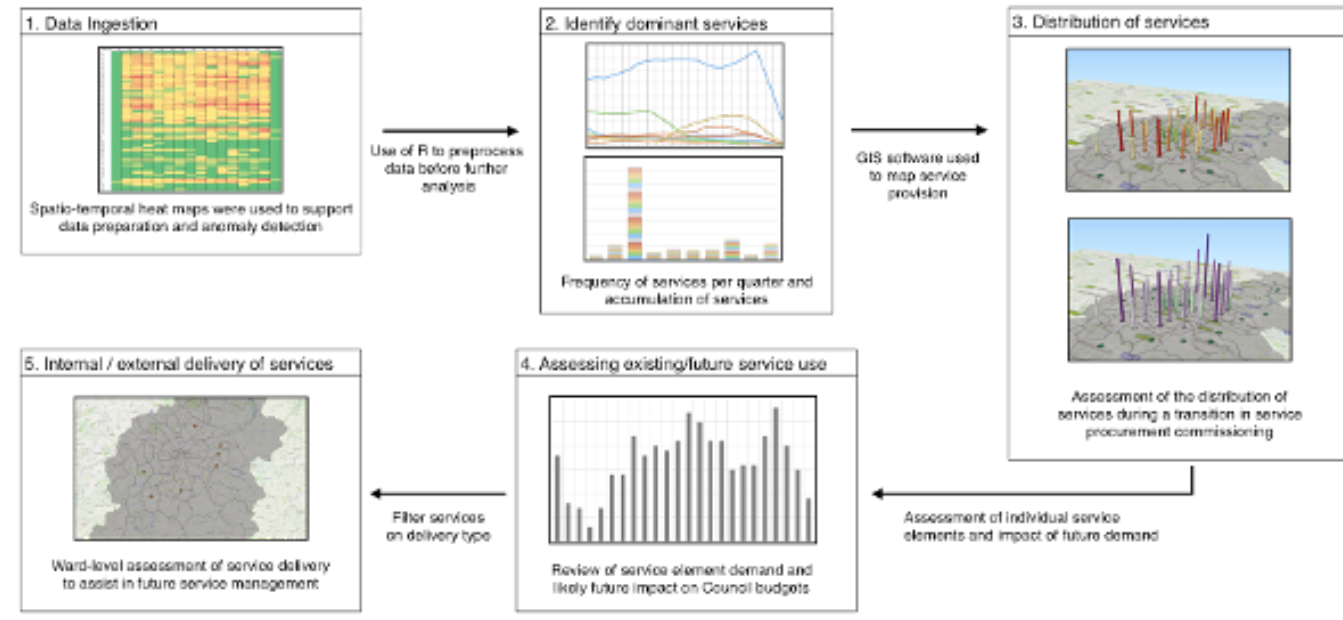
Figure 2: Workflow employed in this